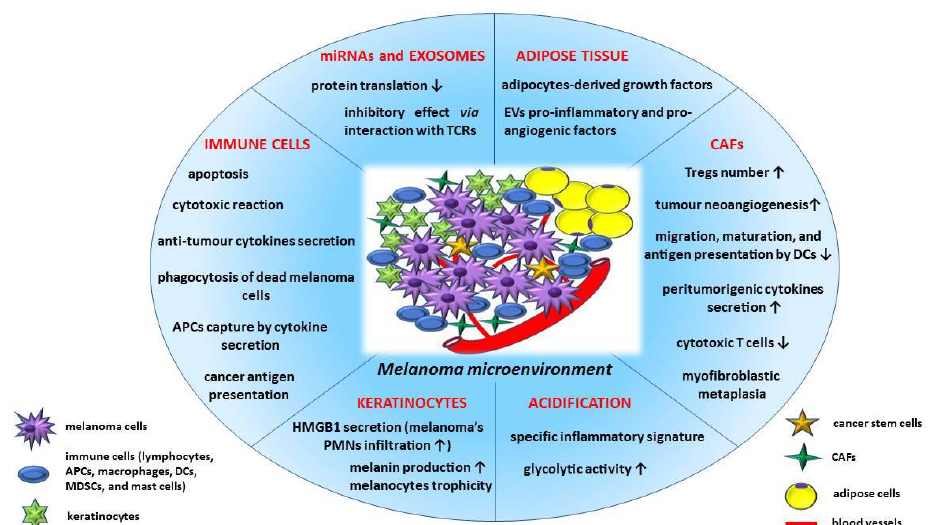
Figure 1. Cellular and extracellular components of melanoma’s microenvironment. The tumour microenvironment (TME) contains numerous cellular and extracellular components, forming together a complex, which supports melanoma development. APCs—antigen-presenting cells; CAFs—cancer- associated fibroblasts; DCs—dendritic cells; EVs—extracellular vesicles; HMGB1- high mobility group box 1 protein; MDSCs—myeloid-derived suppressor cells; miRNAs—microRNAs; PMNs— neutrophils; TCRs—T cells receptors; Tregs—regulatory T cells; ↑ —increased level; ↓ —decreased